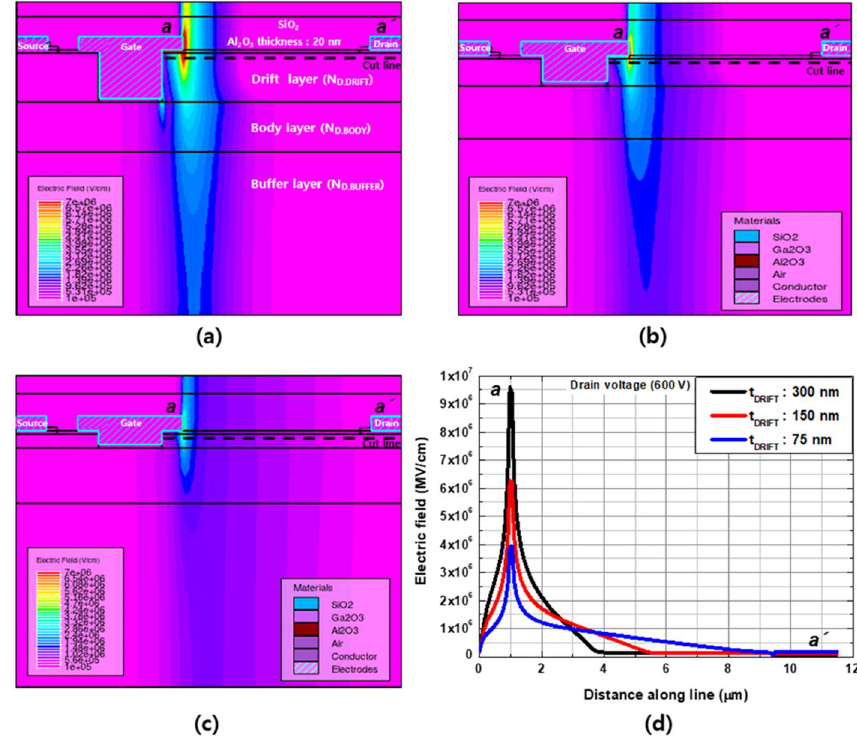
Figure 10. Electric field distributions simulated with V GS = 0 V and V DS = +600 V for a drift channel layer thicknesses of ( a ) 300 nm, ( b ) 150 nm, and ( c ) 75 nm. ( d ) Electric field distribution along the cutline between a and a’.